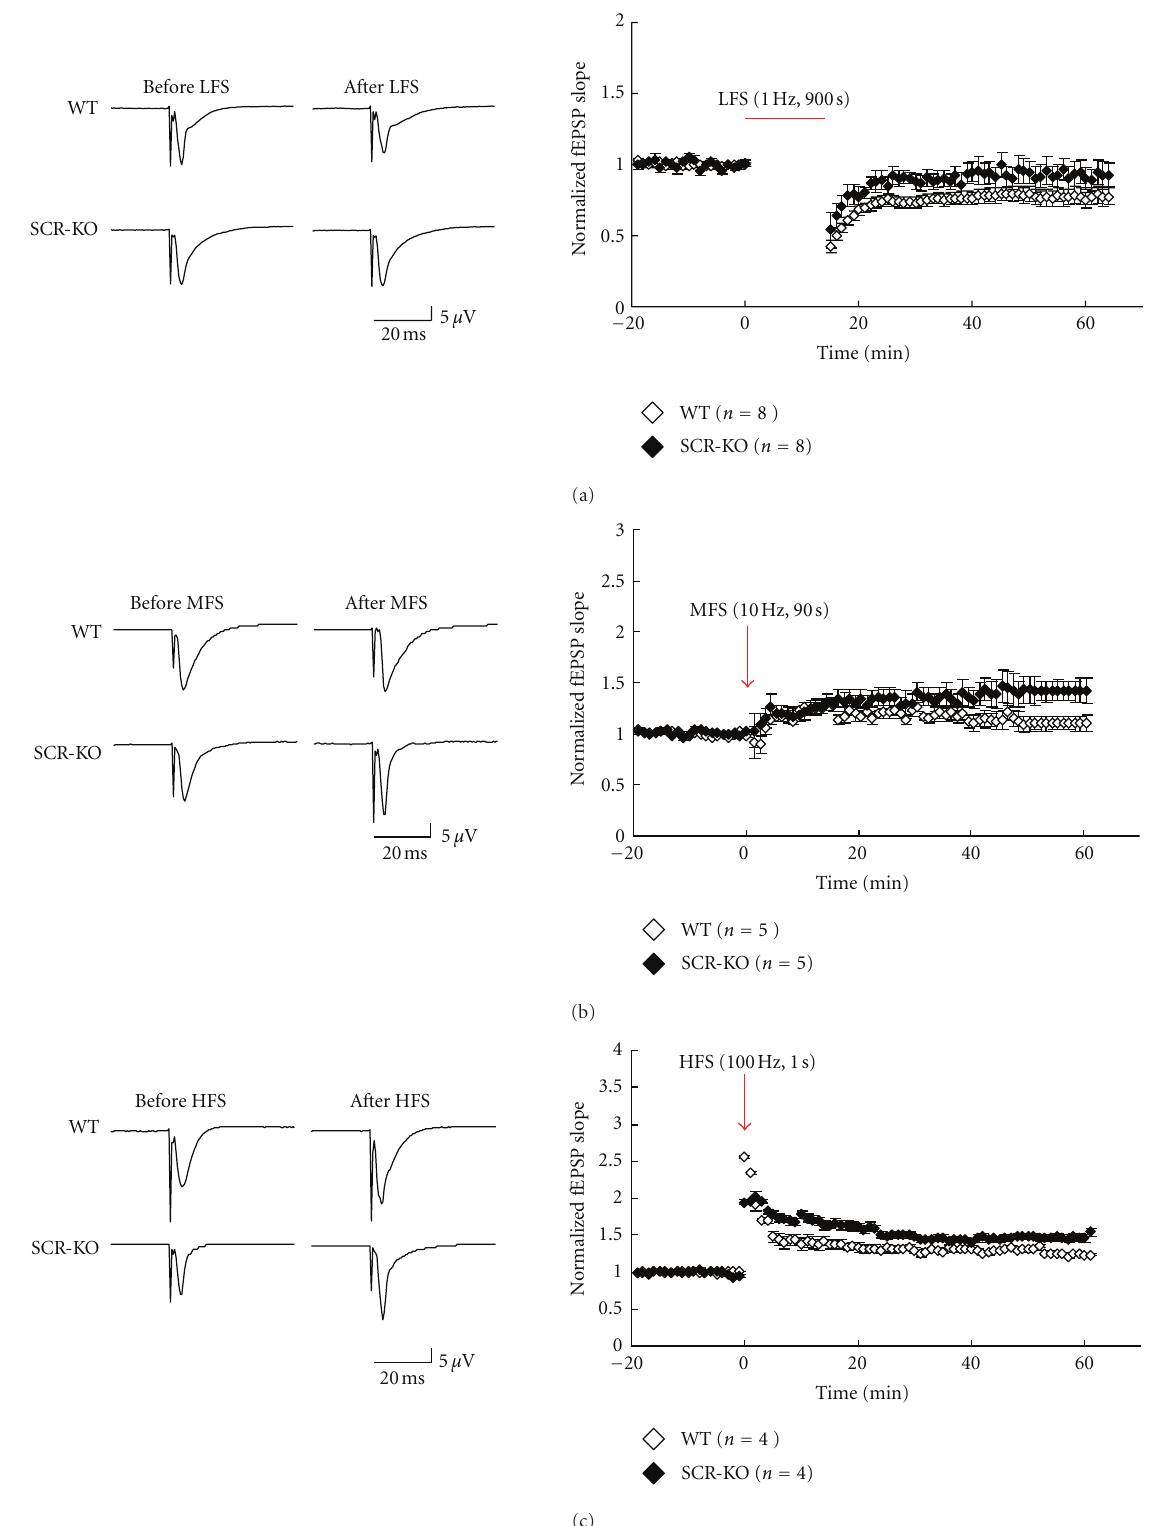
Figure 2: Long-term potentiation/depression (LTP/LTD) induction by stimulation at di ff erent frequencies in wild-type (WT) or Scrapper - knockout (SCR-KO) hippocampal slices. Left column: records of representative experiments in which LTP/LTD was induced. Low-frequency stimulation (LFS, 1Hz, 900s) (a), middle-frequency stimulation (MFS, 10Hz, 90s) (b), or high-frequency stimulation (HFS, 100Hz, 1s) (c) was used as the input. Right column: normalized means ( ± standard error of the mean (SEM)) of field excitatory postsynaptic potential (fEPSP) slopes from WT or SCR-KO hippocampal slices. Each point represents a single measure of the initial slope of the population excitatory postsynaptic potentials (EPSPs) evoked by stimulation of the Scha ff er collaterals at 1/60 Hz. The horizontal bar or the arrow represents the period of stimulation. The number of mice, n = 8,5, and 4 in (a), (b), and (c), respectively. ( ♦ , WT; (cid:3) ,